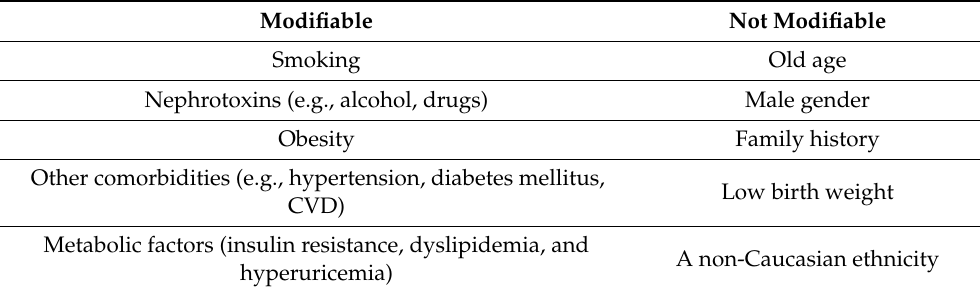
Table 1. Risk factors for chronic kidney disease